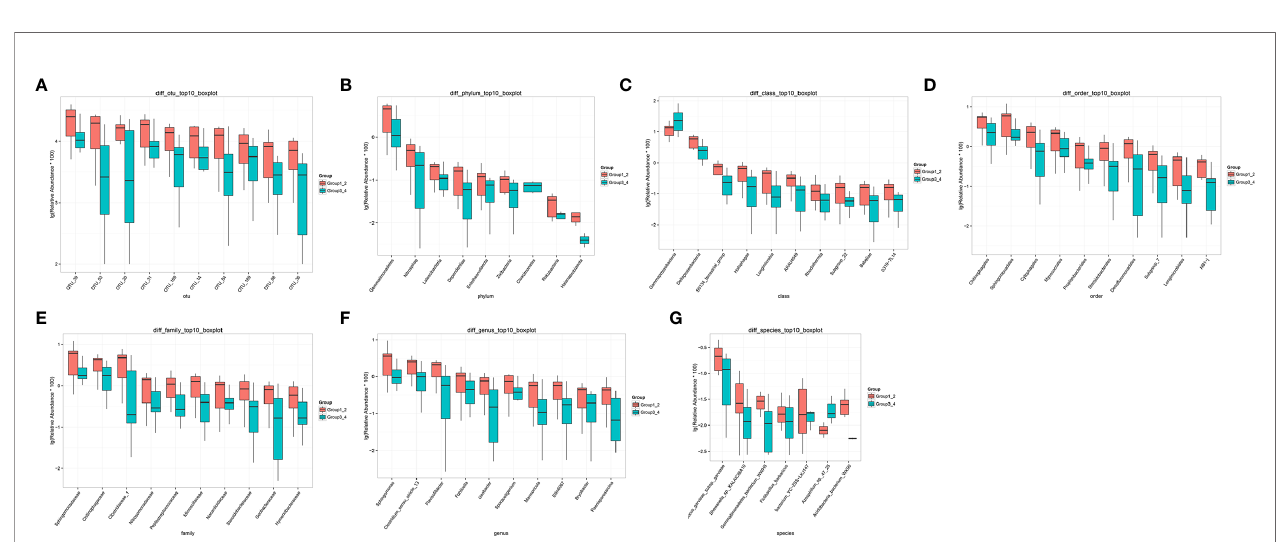
FIGURE 4 | The top 10 different OTU/species at the level of OTU, phylum, class, order, family, genus, and species. (A) OTU, (B) phylum, (C) class, (D) order, (E) family, (F) genus, (G)